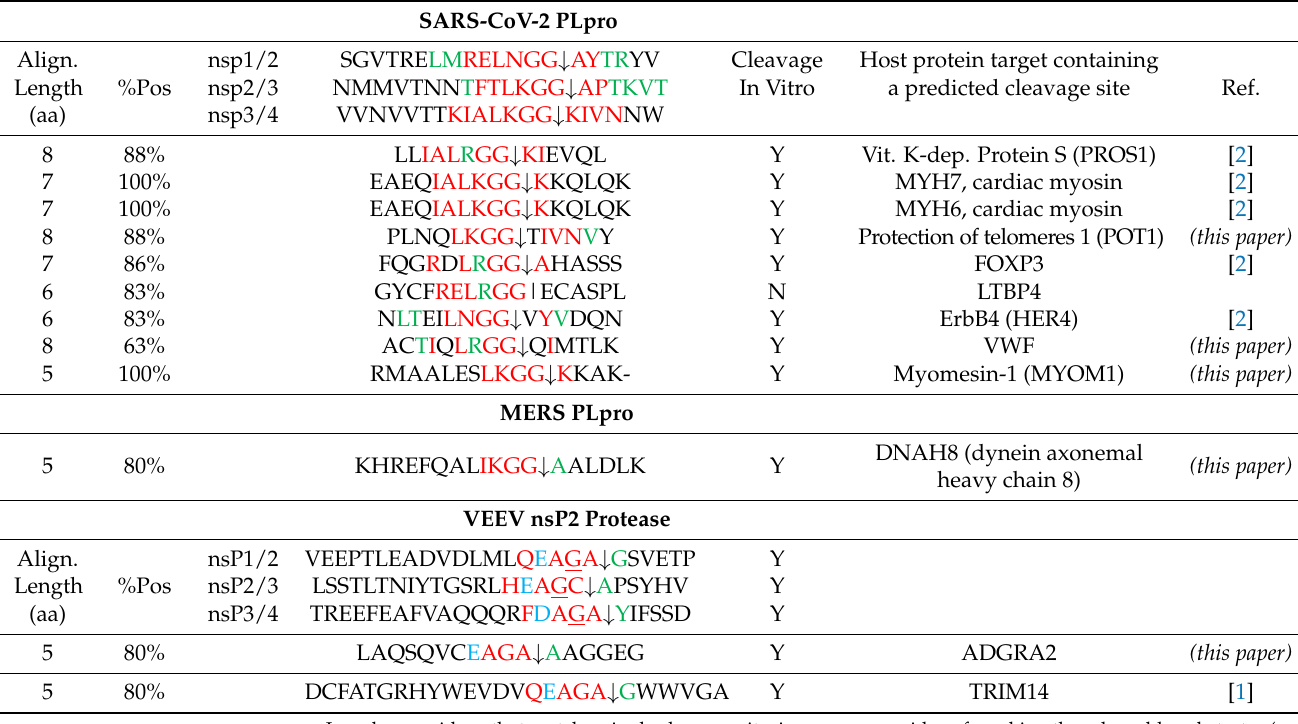
Table 2. Summary of in vitro protease cleavage assay results for SARS-CoV-2 PLpro and VEEV nsP2